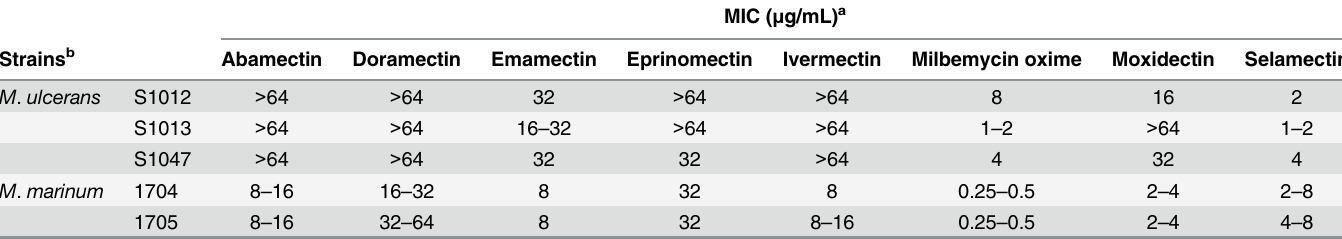
Table 1. Antimicrobial activities of macrocyclic lactones against M . ulcerans and M . marinum